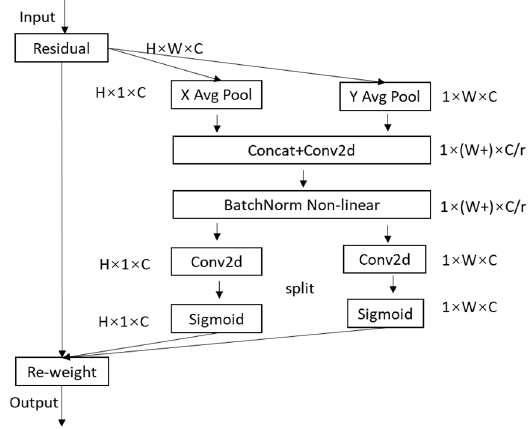
Figure 2. Implementation process of CA attention module.